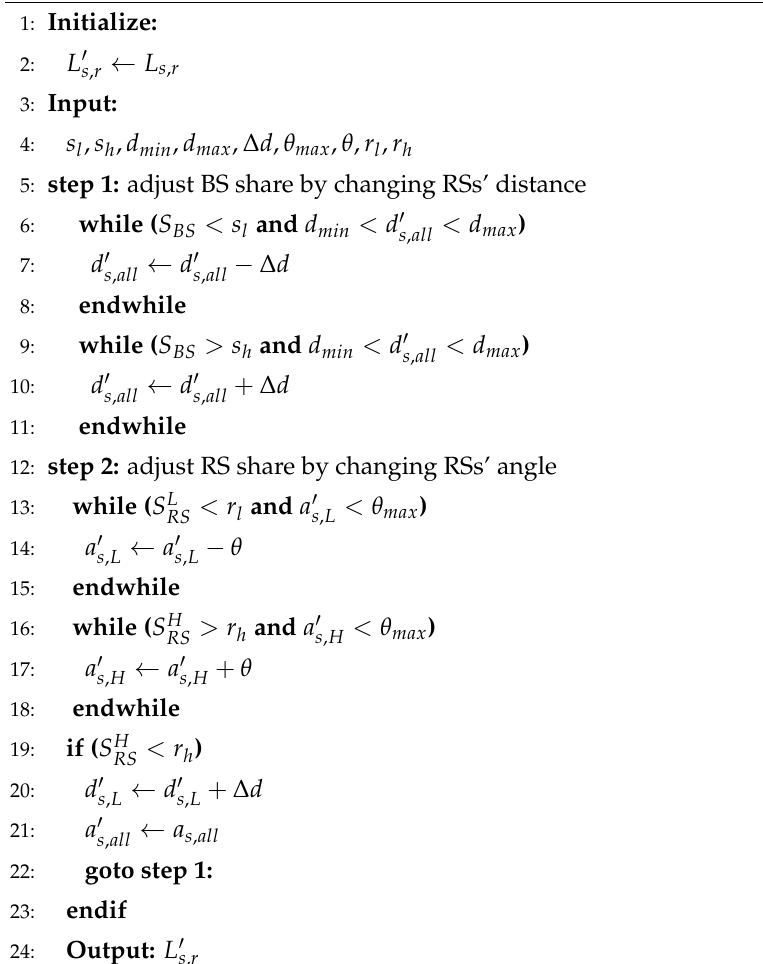
Algorithm 1 RS location for load